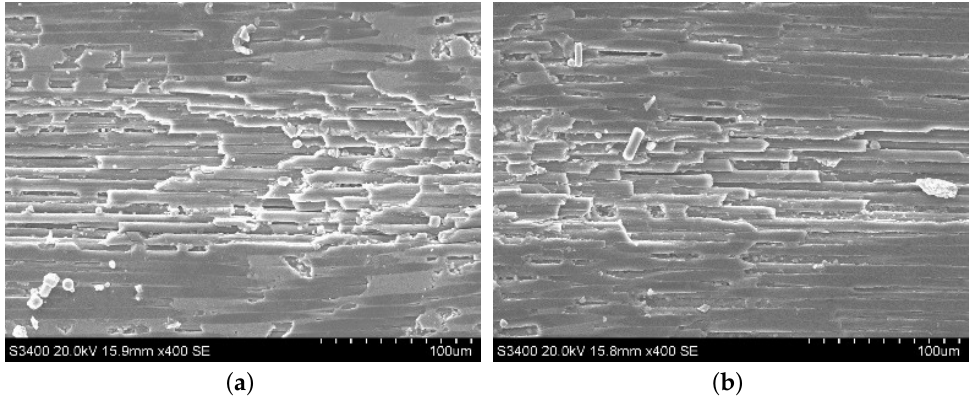
Figure 6. Typical morphologies after cutting C/SiC composites at 0 ◦ . ( a ) is ordinary cutting and ( b ) is ultrasound-assisted